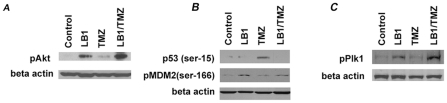
Western blot on MPC cells.Changes in pAKT, p53, pMDM2, and pPlk-1 after 24 hours treatment on MPC cells with 5 µM of LB1, 50 µM of TMZ and combination of both drugs. (A) Western blots show that LB1 exposure increases pAKT compared to control MPC cells (untreated, only vehicle). TMZ does not noticeably change the expression of pAKT and combination of LB1 and TMZ highly increases pAKT expression. (B) A demonstration of markedly increased expression of p53 after TMZ treatment but inhibition of expression by exposure to LB1. Noticeable increase in the expression of pMDM2 in MPC cells treated with LB1 alone or in combination with TMZ. (C) Noticeable increases in expression of pPlk1 in MPC cells after exposure to the combination of drugs.